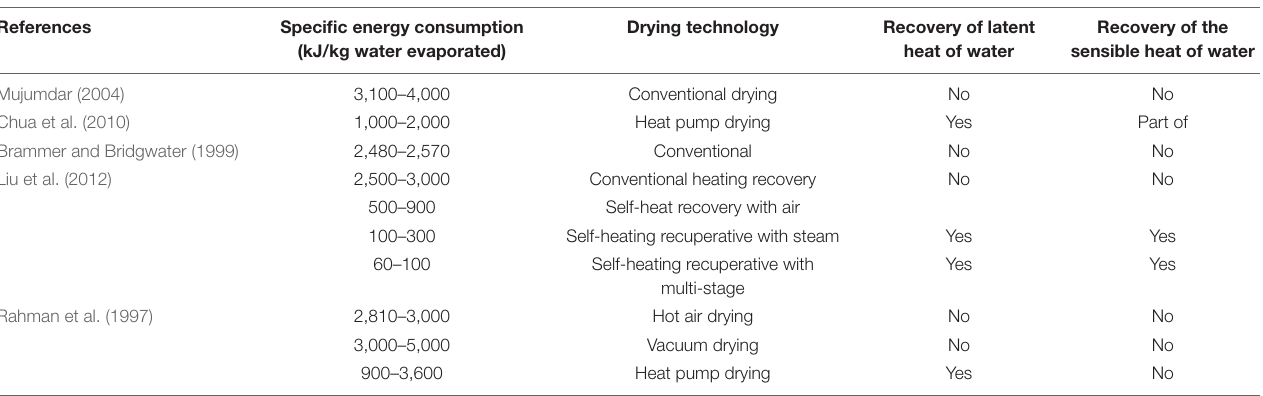
TABLE 2 | Energy consumption of different advanced drying